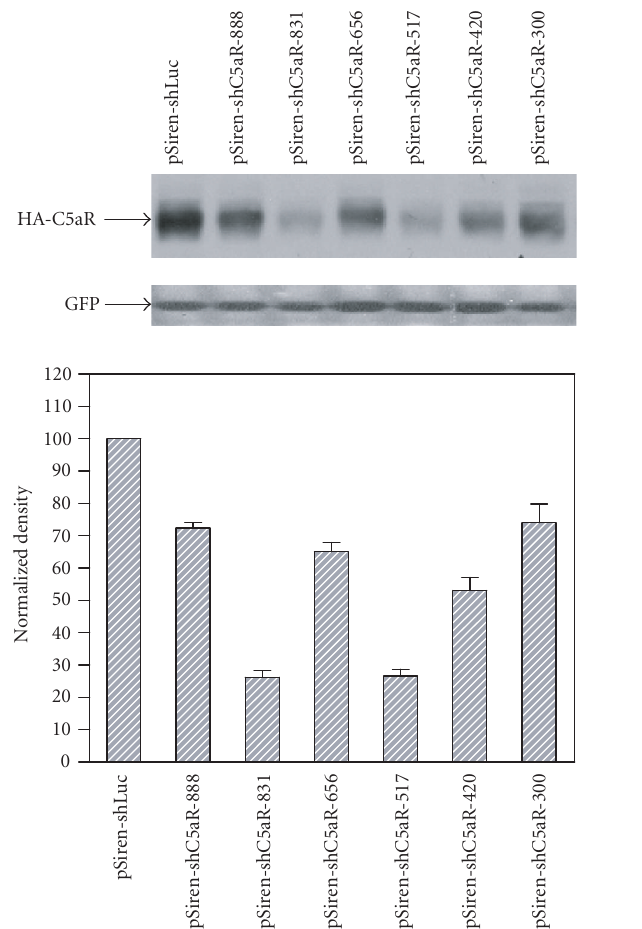
Figure 3: Silencing e ff ects of plasmid-derived short hairpin RNAs. HEK293 cells in 6-well plates were transfected with 4 µ g of a 10:1 mix of pSIREN-DNR-DsRed-shRNA to HA-tagged C5aR together with 0.3 µ g gfp plasmid. Forty-eight hours after transfection, cell lysates were analyzed by Western-bloting for HA (upper panel). Expression of gfp showed equal transfection e ffi ciency. The bot- tom panel showed the quantitative densitometric analysis of bands shown in the upper panel. The percentage of inhibition was normal- ized to control cells transfected with luciferase-shRNA. Averages are derived from 3 to 5 independent experiments (standard deviations are indicated).